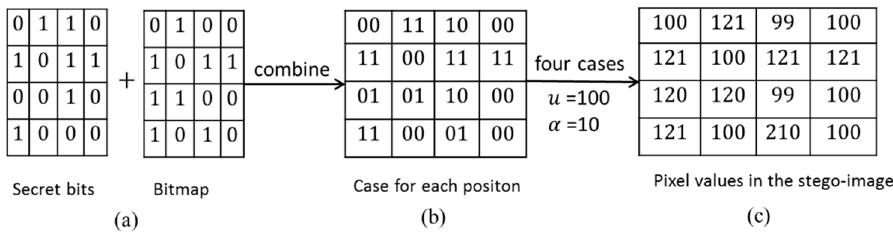
Figure 2. Example of Lin et al.’s hiding strategy.